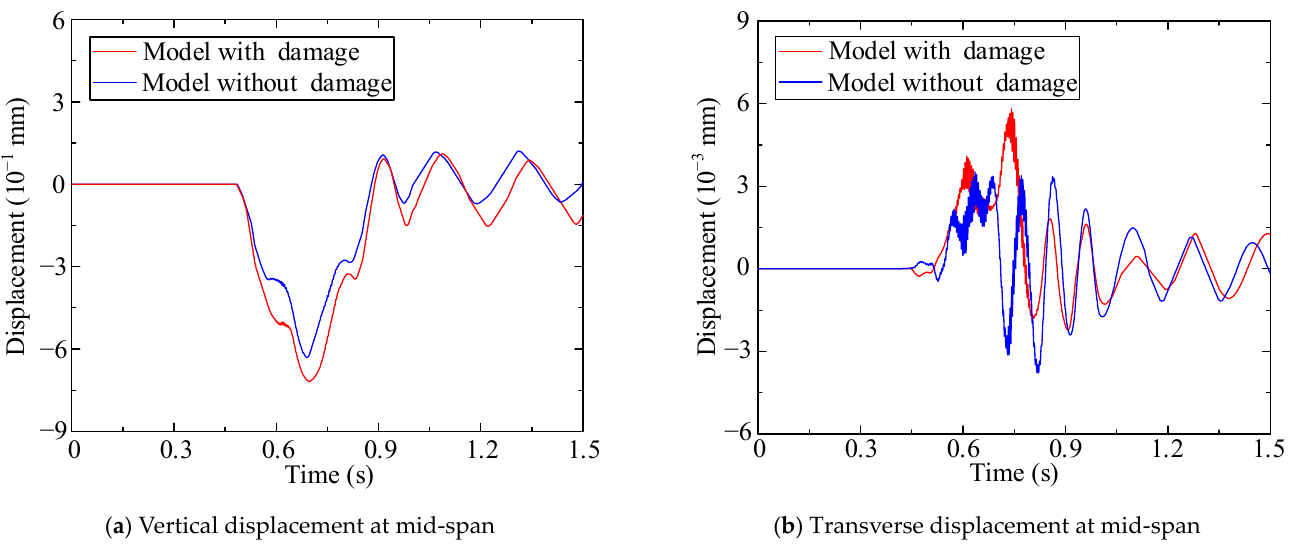
Note: Y is the vertical mid-span displacement of the composite beam; X is the lateral mid-span dis- placement of the composite beam.